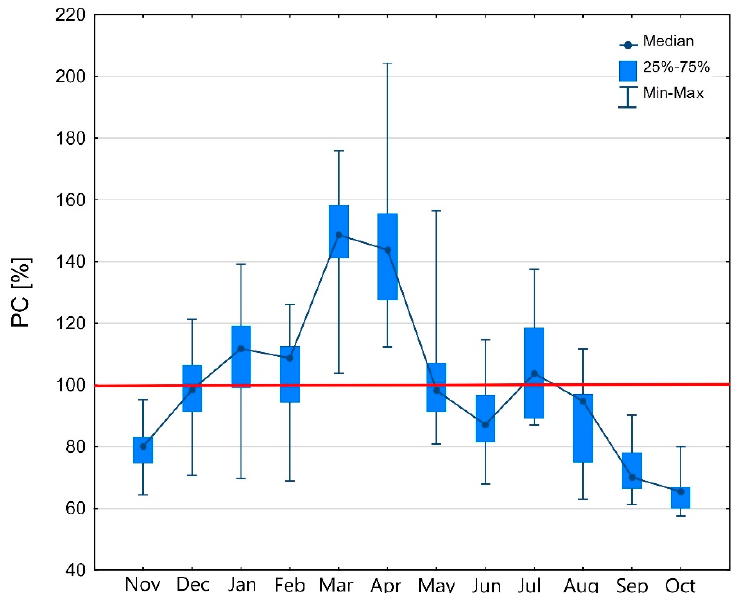
Figure 2. Range of variability of the Pardé’s coefficients (PC) of the analyzed rivers in Polish Sudeten in 1971–2015. In the boxplot, monthly median values are marked with black dots, range of the 1st and 3rd quartile are marked by box, and the whiskers show extreme values.